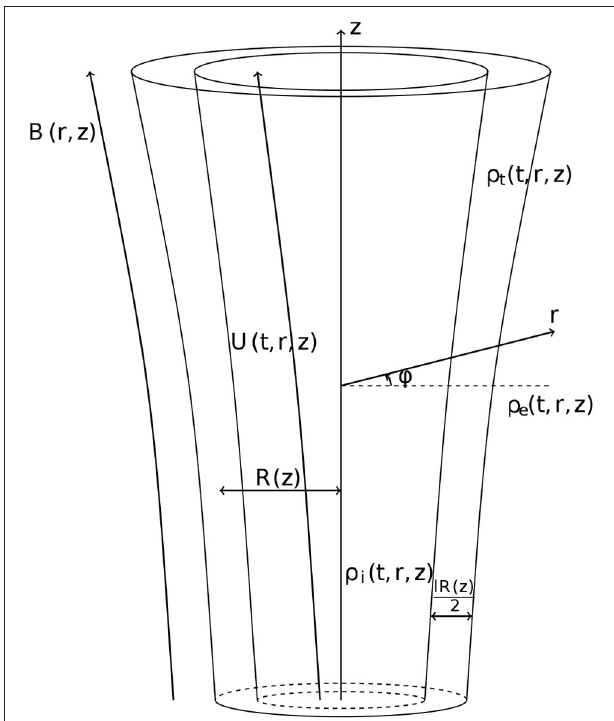
FIGURE 1 | Sketch of the